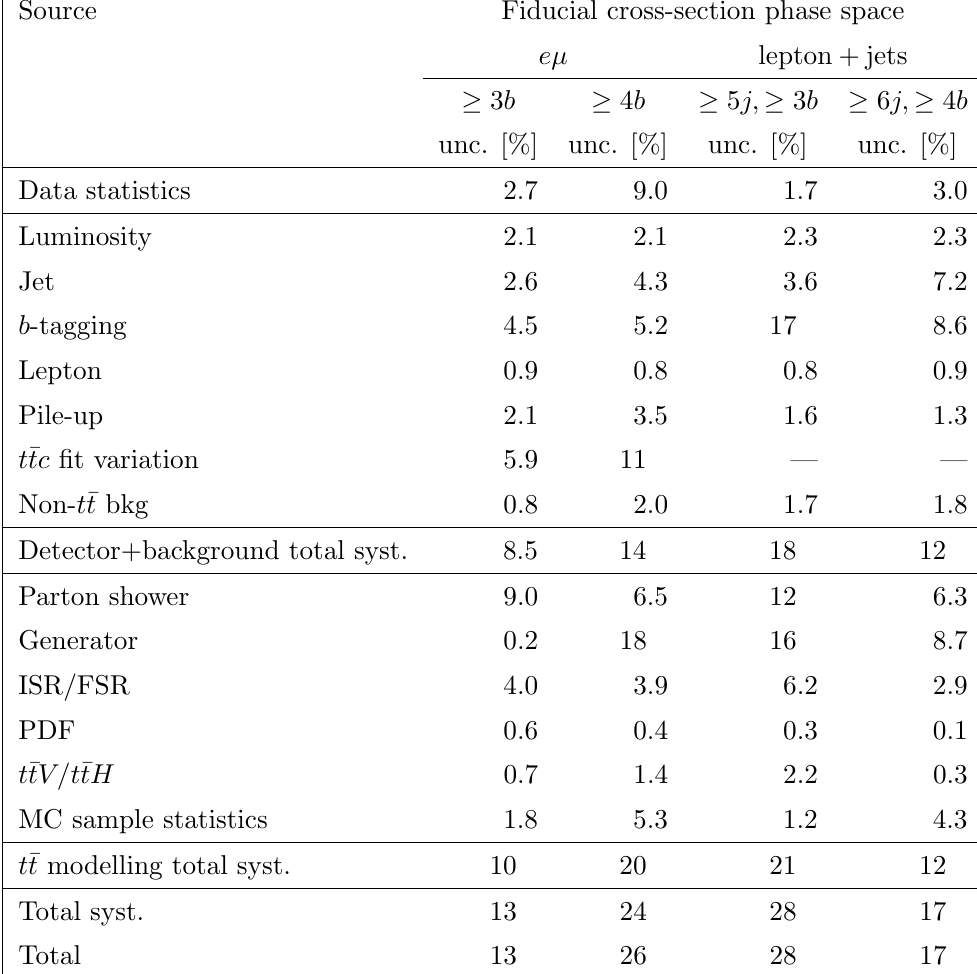
Table 6. Main systematic uncertainties in percentage for particle-level measurement of inclusive cross-sections in (cid:21) 3 b and (cid:21) 4 b phase